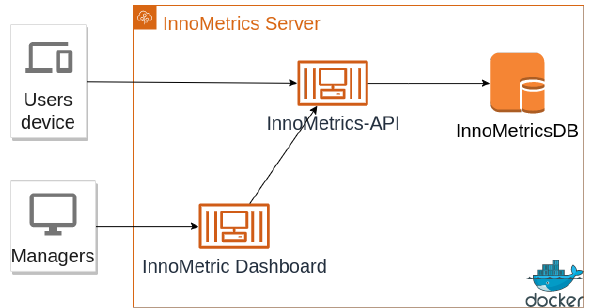
Figure 2. Physical view of the